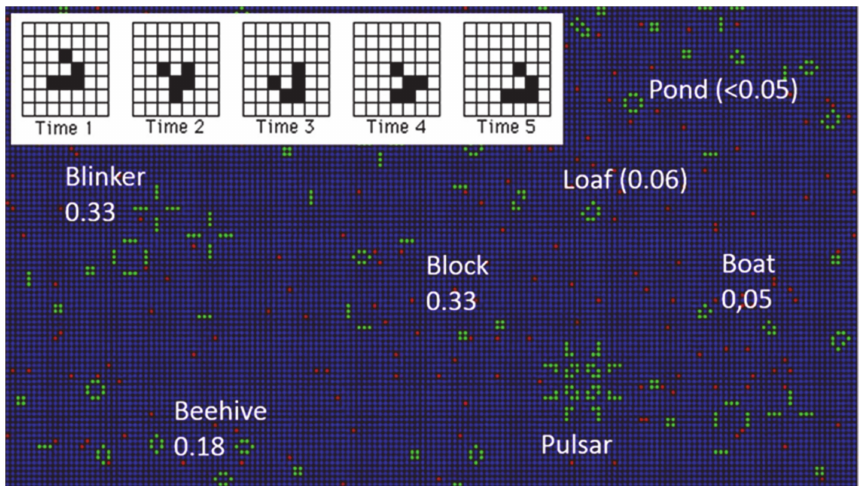
Figure 1. (Color online) Example of the most common stable clusters in the GoL (blinkers, blocks, beehives, etc.) and an example of a not-so-common cluster (pulsar). Green cells are the active cells, blue are inactive, and red ones represent defects (see Section 5). Numbers stand for the probability of appearance [42]. Inset. Glider and its movement. Active cells are represented by a black square, while inactive cells are empty. This glider moves diagonally downward and to the right by one cell every four